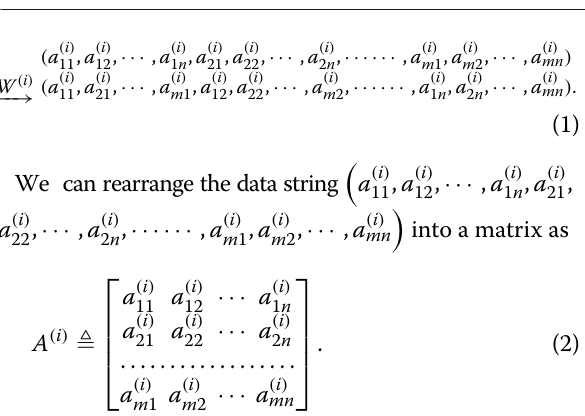
( i ) ( i ) ··· , a ( i ) a mn m 1 , m 2 ,